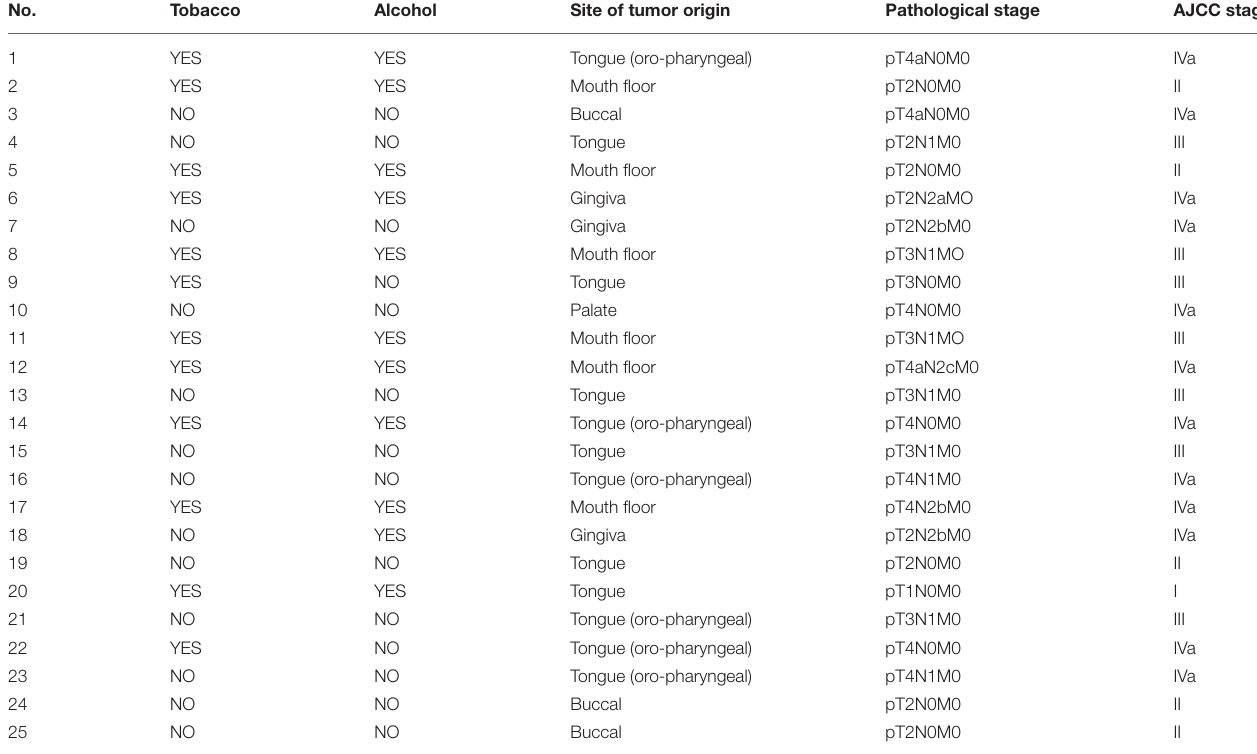
TABLE 1 | Clinicopathological parameters of enrolled HNSCC patients. No.